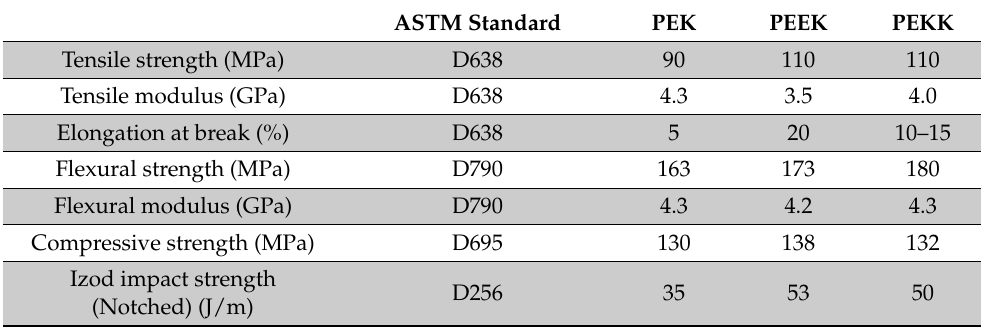
Table 1. Mechanical properties of PEK and PEEK and PEKK provided by the